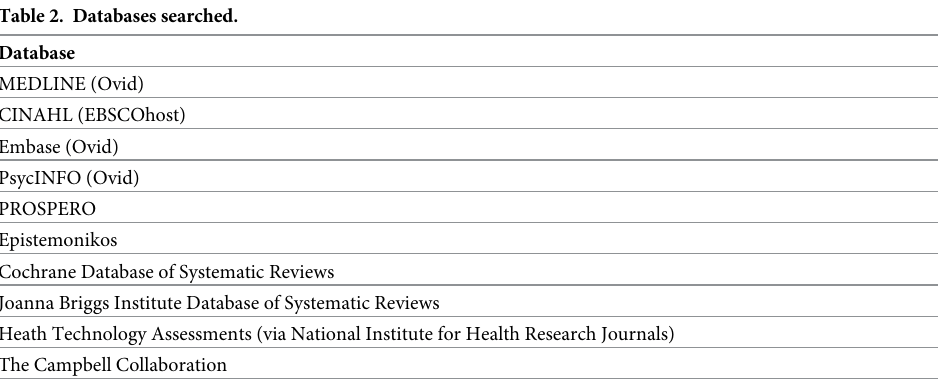
Table 2. Databases